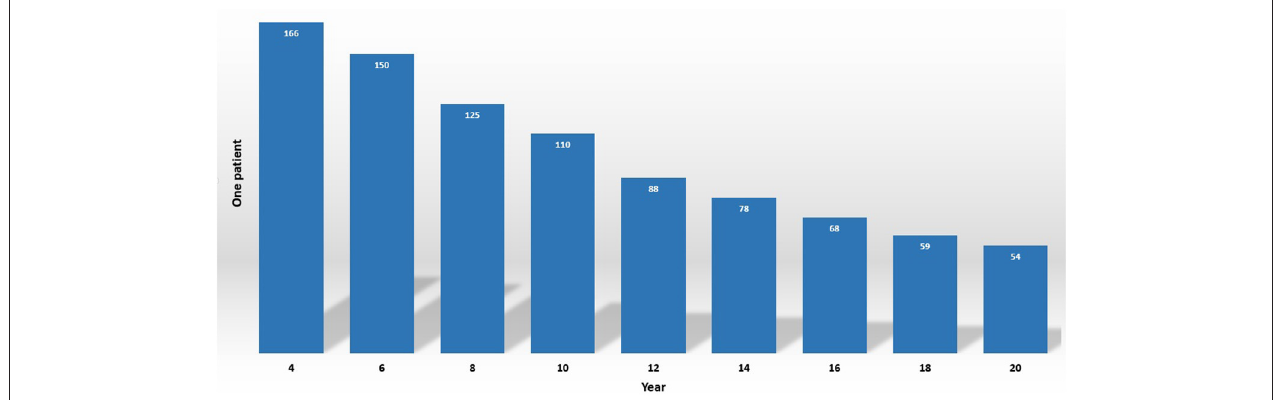
FIGURE 1 | Estimated ASD prevalence of 2020 by